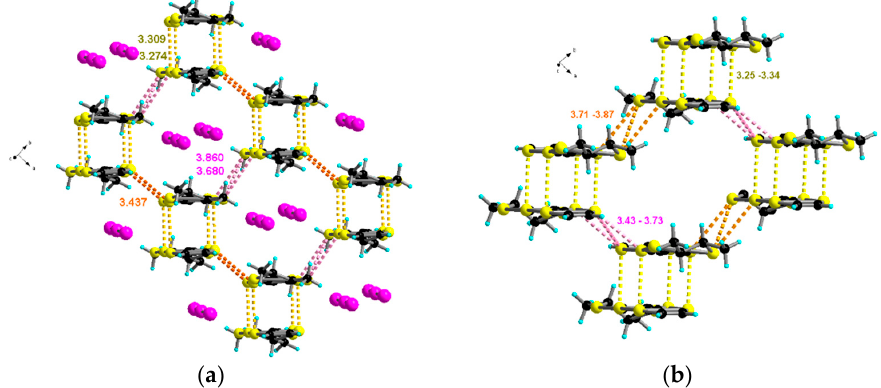
Figure 9. ( a ) Packing of the donors and highlight of the S···S short contacts for [( rac )- 2 ]I 3 ; ( b ) Packing of the donors and highlight of the S···S short contacts for [( R,R )- 2 ]I 3 . The anions are not shown. The intradimer S···S distances of 3.27–3.31 Å for [( rac )- 2 ]I 3 and 3.25–3.34 Å for [( R,R )-